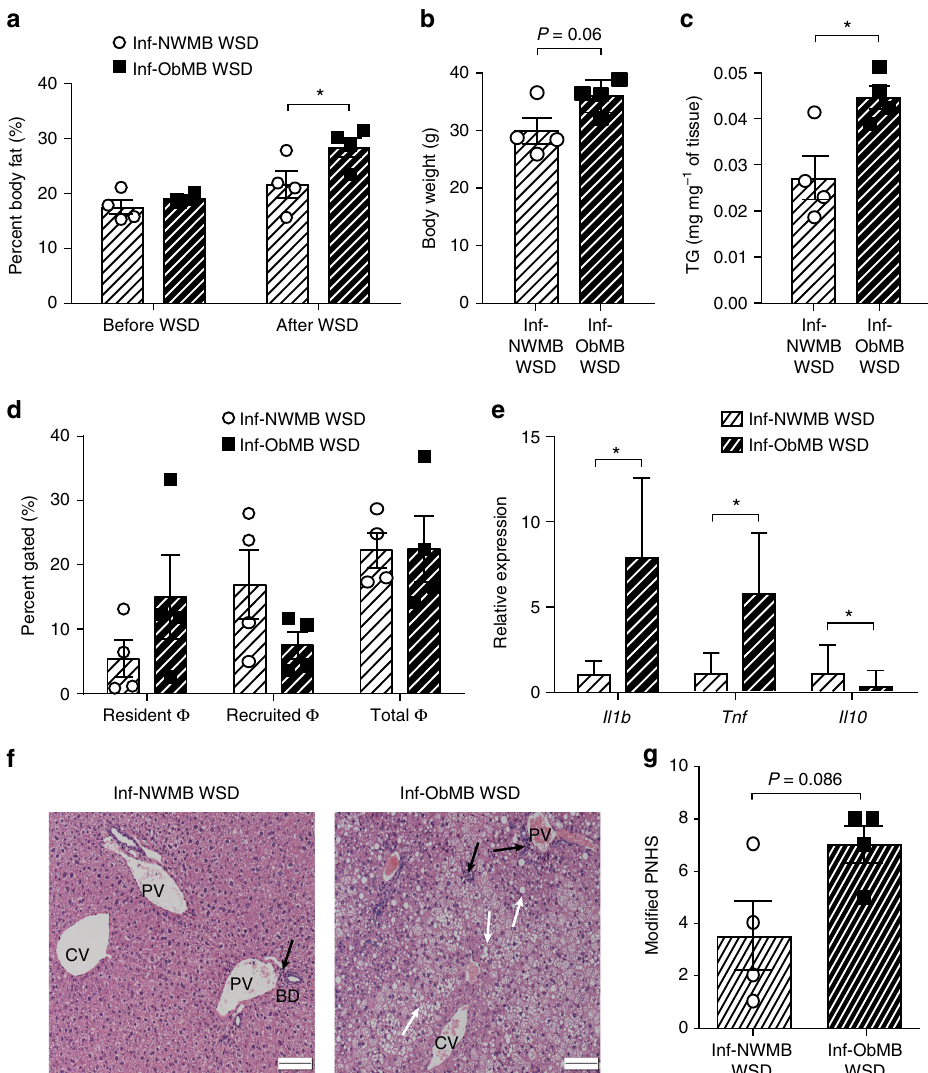
Fig. 6 Inf-ObMB phenotype is exacerbated by WSD. a Percent body fat before and after 6 weeks of WSD. Inf-NWMB and Inf-ObMB mice after 6 weeks on WSD for body weight ( b ), liver triglycerides (TG) ( c ), liver macrophage ( Φ ) quantity ( d ), and proin fl ammatory Il1b , Tnf , and anti-in fl ammatory Il10 gene expression in recruited macrophages from liver, normalized to Gapdh and 18S rRNA ( e ). a – e n = 4 for both Inf-NWMB and Inf-ObMB. Data are presented as mean ± SEM. * P < 0.05 by two-tailed Student ’ s t -test. f Representative photomicrographs of liver sections with H&E staining; black bars represent 100 μ m, black arrows indicate in fi ltrating lymphocytes, white arrows indicate lipid droplets; CV central vein; PV portal vein; BD bile duct. g Modi fi ed Pediatric NAFLD Histological Score (PNHS) for Inf-NWMB and Inf-ObMB mice fed a WSD. n = 4 for both Inf-NWMB and Inf-ObMB. Data are presented as mean ± SEM. P = 0.086 by two-tailed Mann – Whitney U